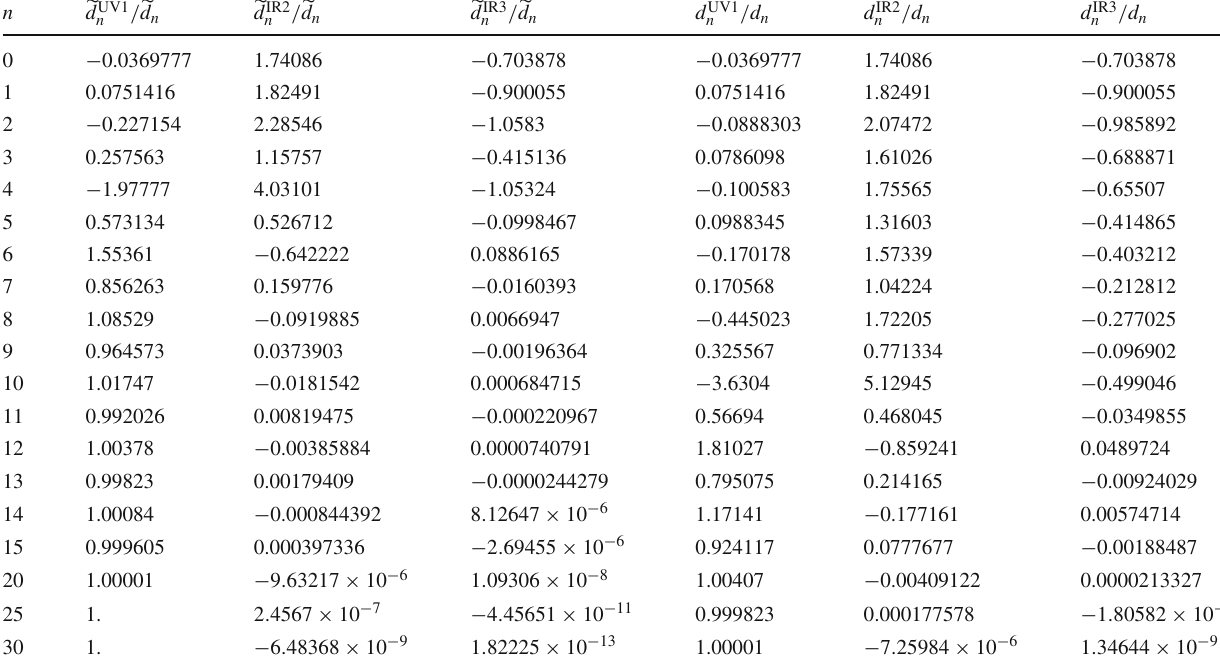
Table 8 The ratios of (cid:8) d X n / (cid:8) d n and d X n / d n for the separate renormalon contributions X= UV1, IR2, IR3 ( κ = 1). See the text for details